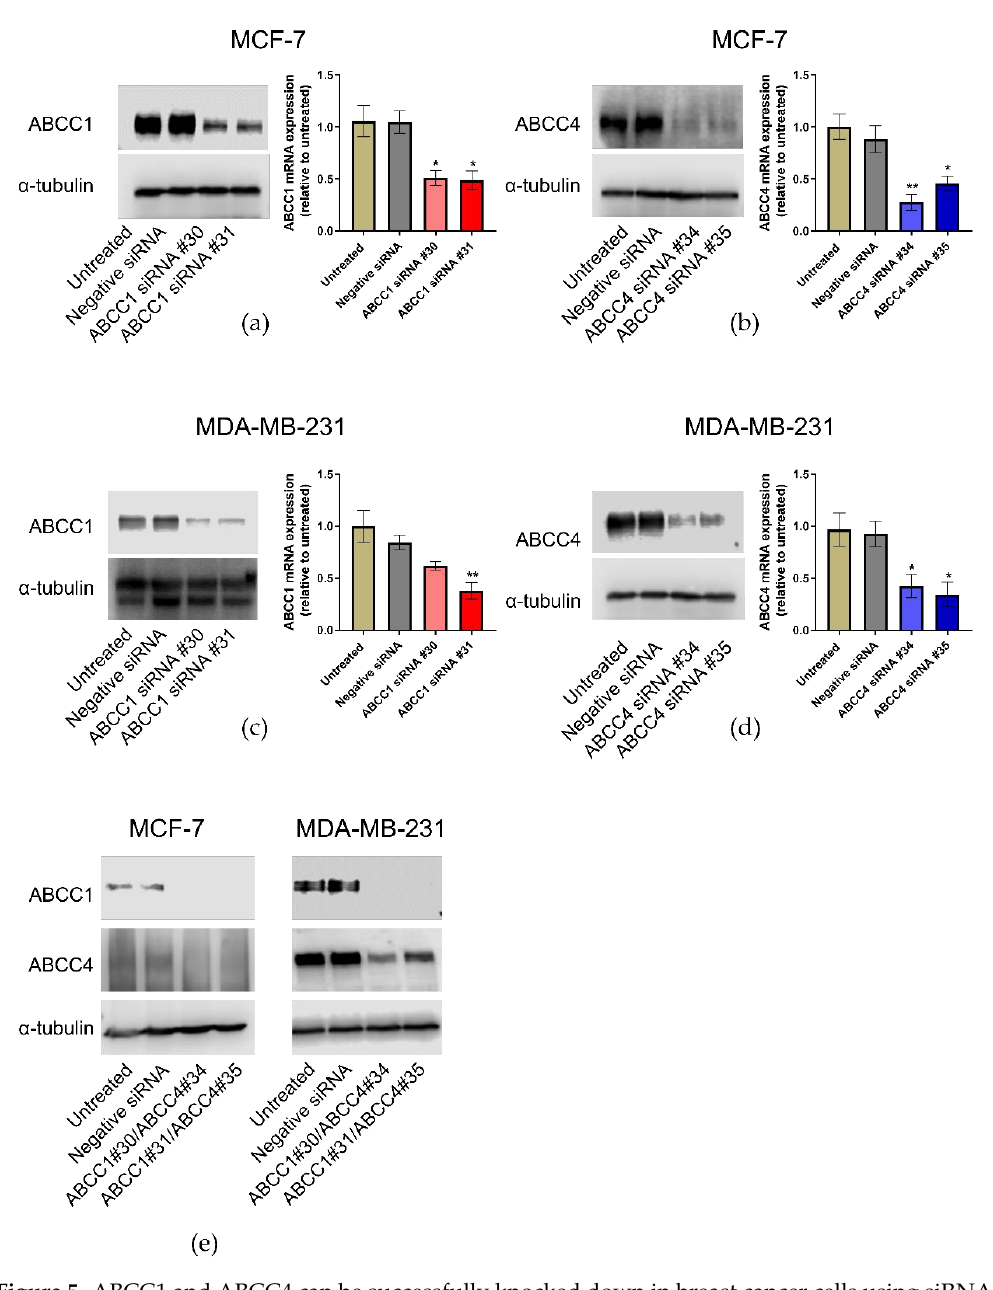
Figure 5. ABCC1 and ABCC4 can be successfully knocked down in breast cancer cells using siRNA. Gene knockdown in breast cancer cells was performed using the INTERFERin-siRNA transfection protocol, with two different ABCC1 siRNAs (#30 or #31), two different ABCC4 siRNAs (#34 or #35), or in combination (#30/#34 or #31/#35). A negative control siRNA was also used. The effectiveness of the knockdown was measured by both RT-qPCR and Western blotting. ( a ) Knockdown of ABCC1 in MCF-7 cells, ( b ) knockdown of ABCC4 in MCF-7 cells, ( c ) knockdown of ABCC1 in MDA-MB-231 cells, ( d ) knockdown of ABCC4 in MDA-MB231 cells and ( e ) double knockdown of both transporters in each cell line. Uncropped images can be found in Figure S4. RT-qPCR data are mean ± sem, n = 3. Data were analyzed using a one-way ANOVA with a Dunnett’s post hoc test. * p < 0.05 and ** p < 0.01 significantly lower than the negative siRNA sample.